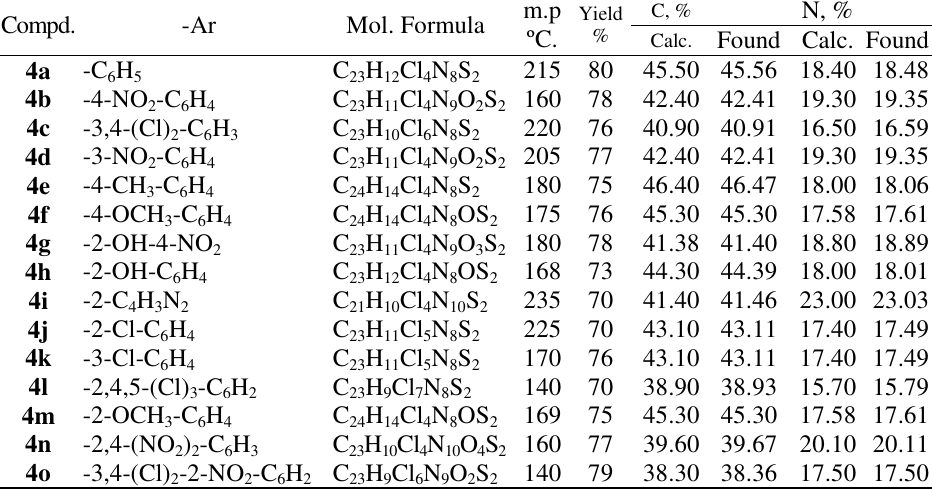
Table 1. Physical constant of the compounds ( 4a-u